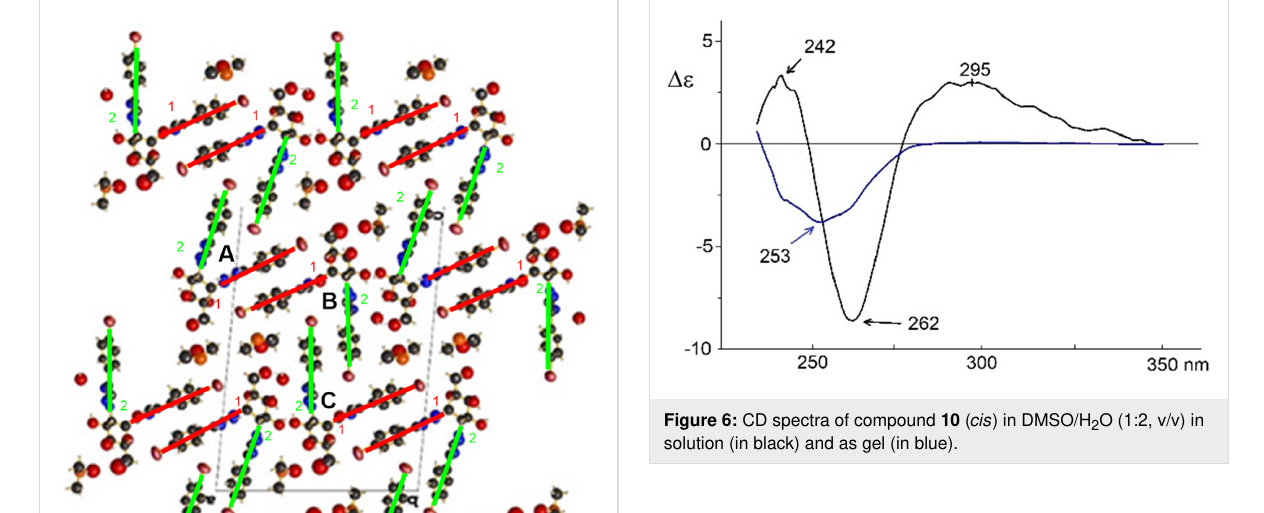
formed hydrogen bonds between the hydroxymethyl groups in position 6 and DMSO molecules while in a gg rotamer confor- mation. The different types of EDC spectra obtained for com- pound 10 in solution (exciton) and in gel (non-exciton), using DMSO/H 2 O, 1:2, v/v, is in total agreement with the supramo- lecular structure of the crystal packing of this compound (Figure